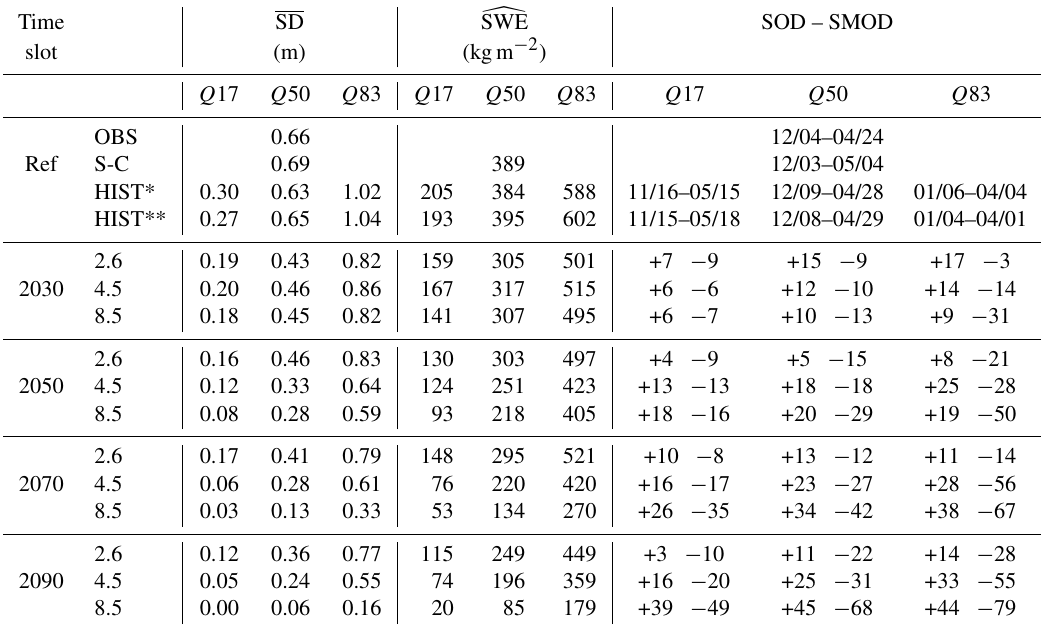
Table 2. Quantile values ( Q 17 = 17%, Q 50 = 50%, Q 83 = 83%) over 15-year windows, for the reference period 1986–2005 (Ref) in observations (OBS, only Q50), SAFRAN-Crocus (S-C, only Q 50) and historical scenario (HIST, * 13 GCM–RCM pairs, ** 4 GCM–RCM pairs corresponding to the ones in RCP2.6), and around the time slots 2030, 2050, 2070 and 2090 for each future scenario (RCP2.6: 4 pairs; RCP4.5 and RCP8.5: 13 pairs), for SD, (cid:91) SWE and SOD – SMOD (mm/dd – mm/dd; for RCPs, number of days earlier or later compared to HIST* SOD and